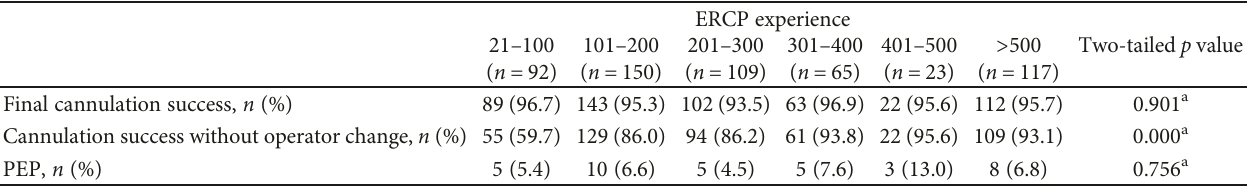
Table 4: The relationship between the ERCP experience and cannulation success rate or PEP.